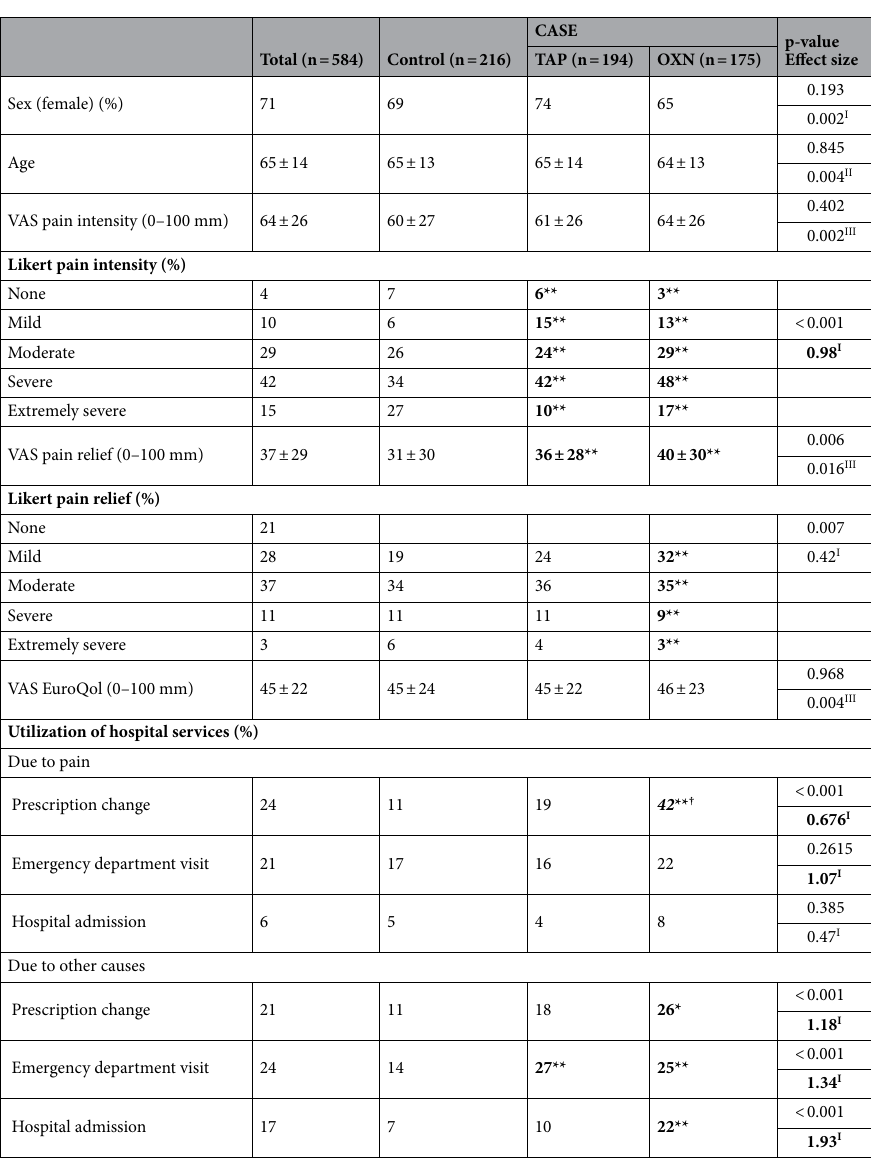
Table 1. Demographic, clinical, and pharmacological data in chronic non-cancer pain patient’s total population, control, and tapentadol (TAP) and oxycodone/naloxone (OXN) cases groups. Data is presented as mean ± SD or as %. Comparison cases vs. control, *p < 0.05, **p < 0.001 and † p < 0.05 tapentadol vs. oxycodone/ naloxone, cell in italics. Chi-square χ 2 the effect size was determined using I Cramer’s V (effect size < 0.2